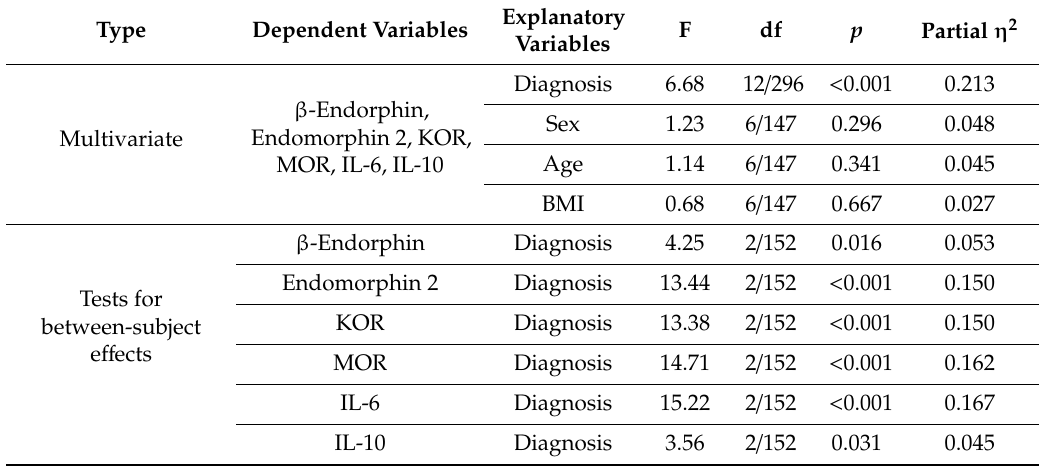
Figure 1. Bar plot showing the mean ( ± 1 SE) z scores of psychosis, hostility, excitement, mannerism, formal thought disorders (FTD), psychomotor retardation (PMR) and the total score on the Scale for the Assessment of Negative Symptoms (SANS) in healthy controls (HC), partial responders to treatment (PRTT) and non-responders to treatment (NRTT). Table 3. Results of multivariate GLM analysis showing the associations between biomarkers and diagnosis while adjusting for background